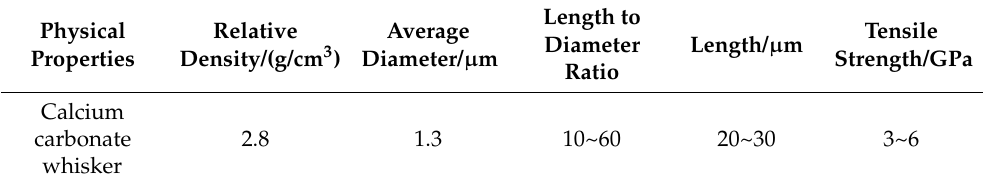
Table 3. Technical specifications of calcium carbonate